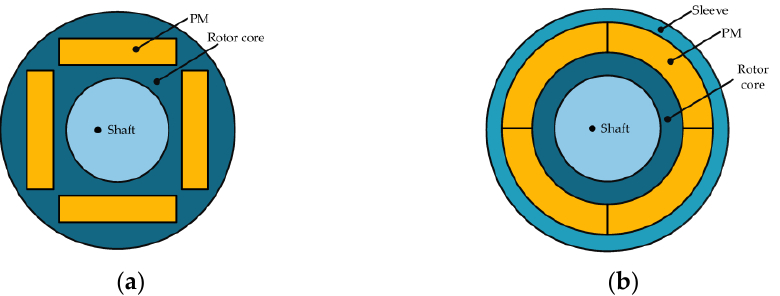
Figure 6. Schematic representation of permanent magnet synchronous motor structure with ( a ) interior rotor; ( b ) exterior or surface rotor layout; with windings and air gaps, replicated from [58].